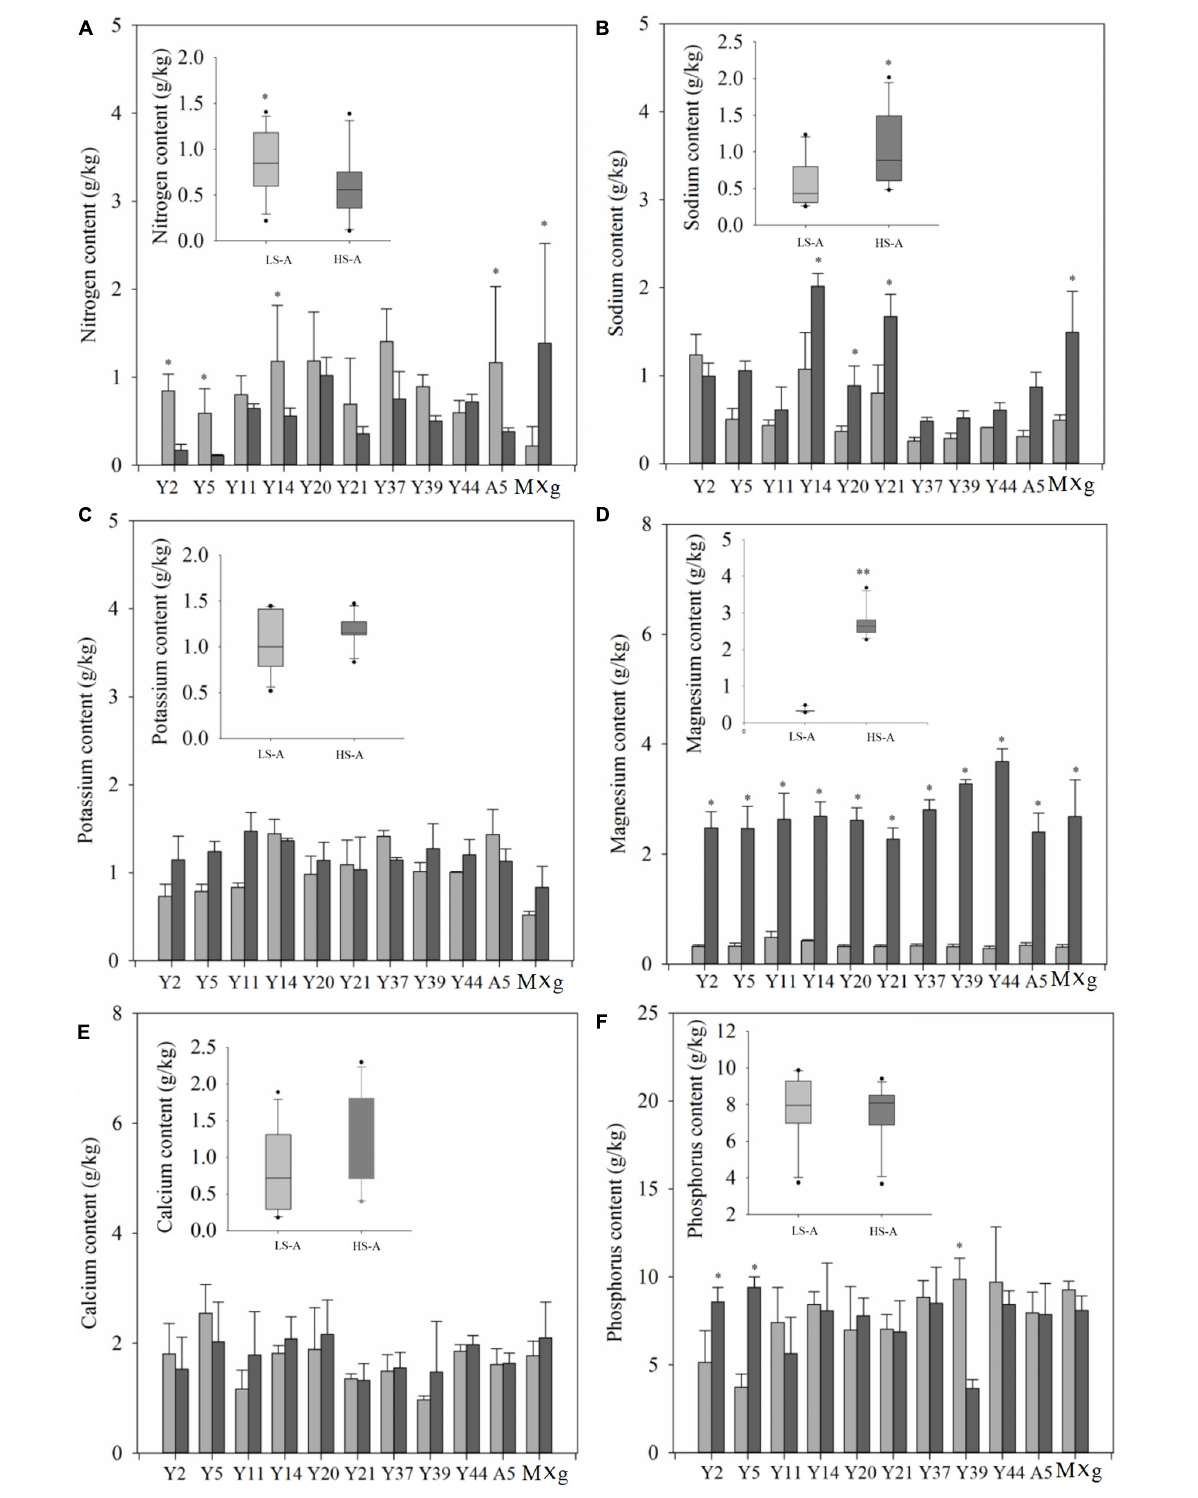
FIGURE6 The nitrogen (A) , sodium (B) , potassium (C) , magnesium (D) , calcium (E) , and phosphorus (F) content of 11 genotypes of Miscanthus grown in low saline–alkaline soil (LS-A) (the light bars) and high saline–alkaline soil (HS-A) (the dark bars). Significance is denoted by ∗ P < 0.05 and ∗∗ P <